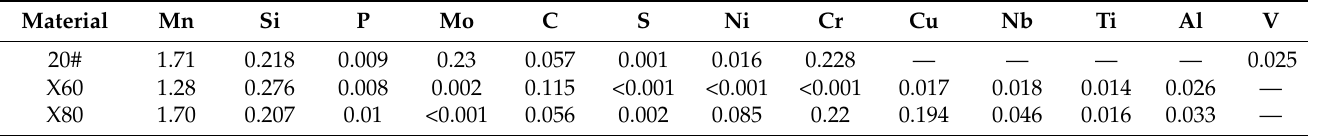
Table 1. Chemical composition of 20#, X60, and X80 steels (wt.